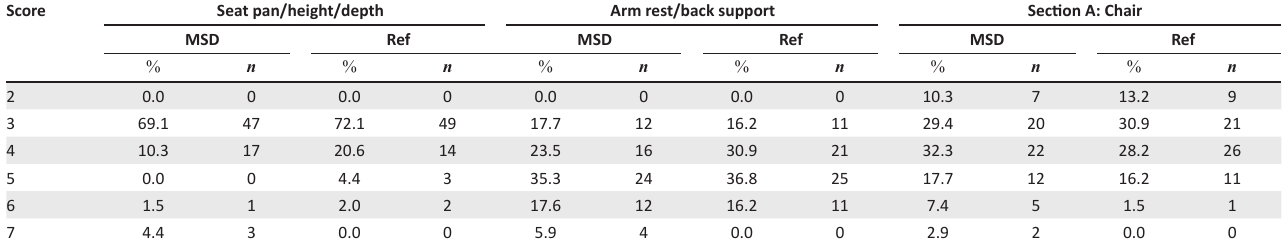
TABLE 5: Sub-scores of the rapid office strain assessment (Section A). Score Seat